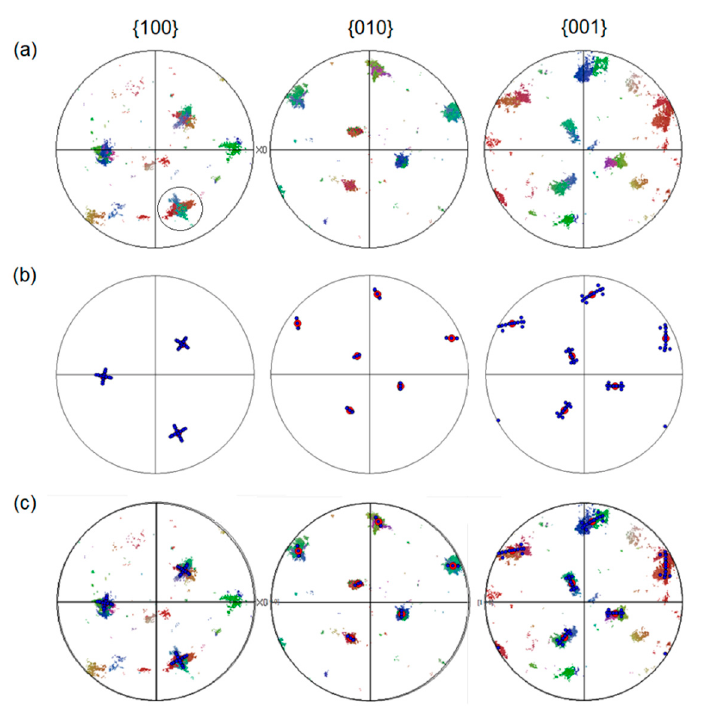
Figure 14. Pole figures of the planes {100}, {010,} and {001} of the B19 ′ martensite ( a ) mapped by TKD in Figure 13 and ( b ) simulated with all the variants generated by the ORs A, AQ, C, CQ, I, and A-C. ( c ) Overlap of the experimental and the simulated pole figures. The circle in ( a ) marks “the four-fold cross” feature that was a “dice-5” in EBSD (Figure 7).